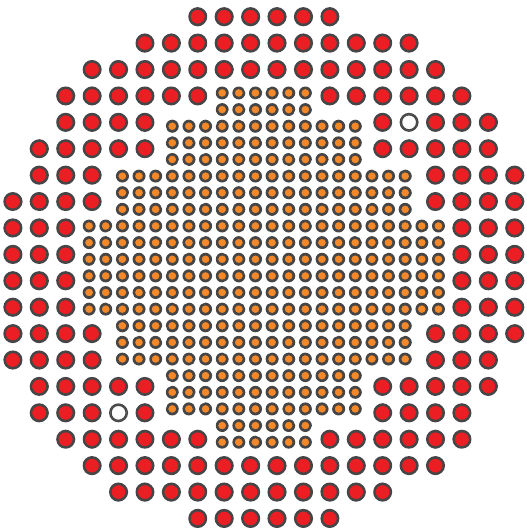
Figure 1: CROCUS core fuel lattices: UO 2 fuel (orange), U-metal fuel (red), and control rods (white).